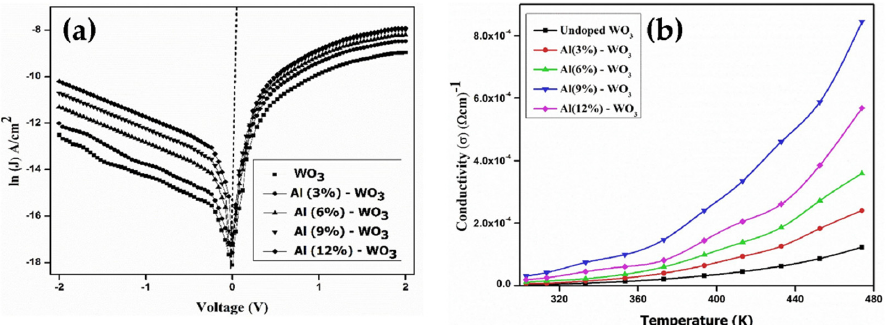
Figure 17. ( a ) ln( J ) − V characteristics of the WO 3 /p − Si diodes for different dopant concentrations of Al. ( b ) Electrical conductivity of the WO 3 thin films for different dopant concentrations of Al as a function of temperature. Reproduced or adapted from [86].